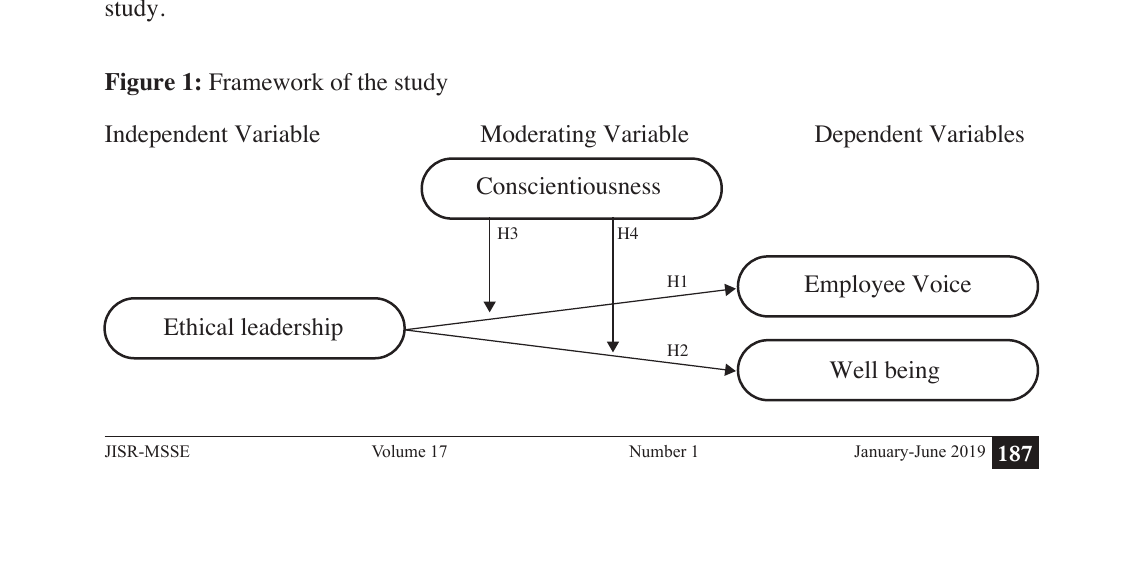
Figure 1: Framework of